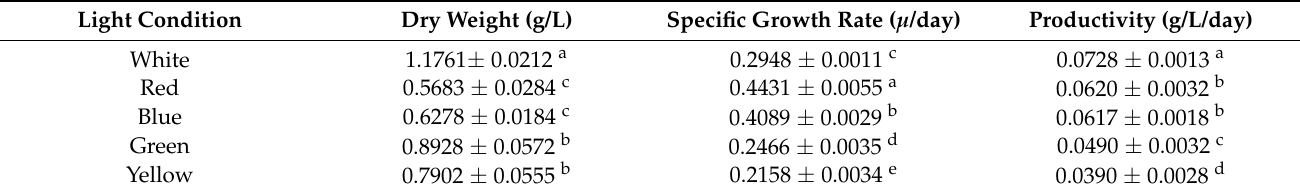
Table 1. Growth parameters of I. zhangjiangensis cultured under different colored